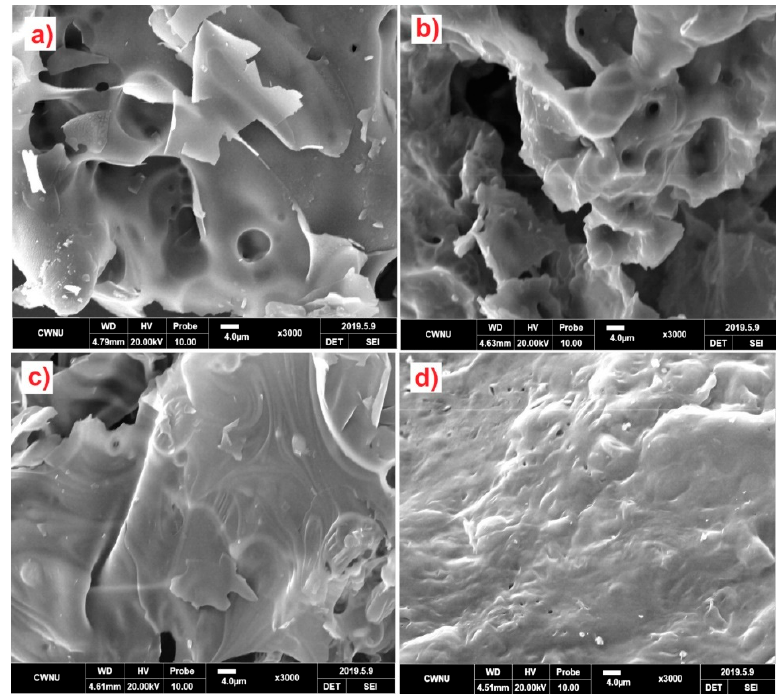
Figure 13. SEM images of the flame retardant char samples ( a ) F0, ( b ) F1, ( c ) F2, and ( d ) F3.